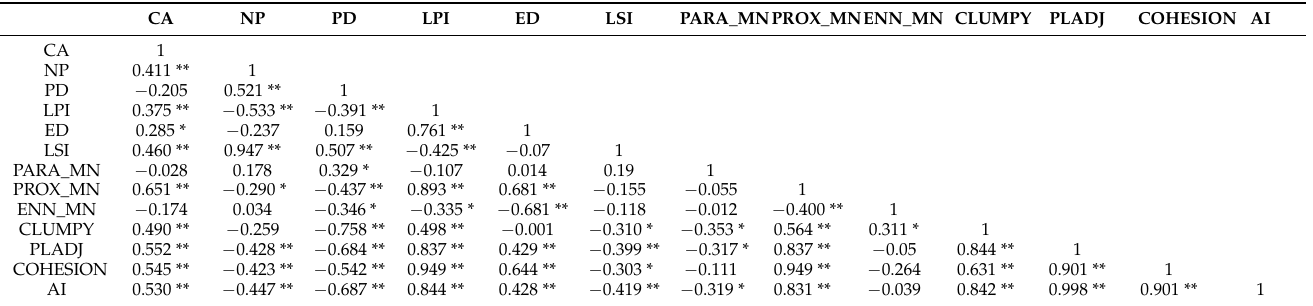
Table 4. Spearman rank correlation coefficient matrix (significance: p < 0.01 ** and p < 0.05 *).